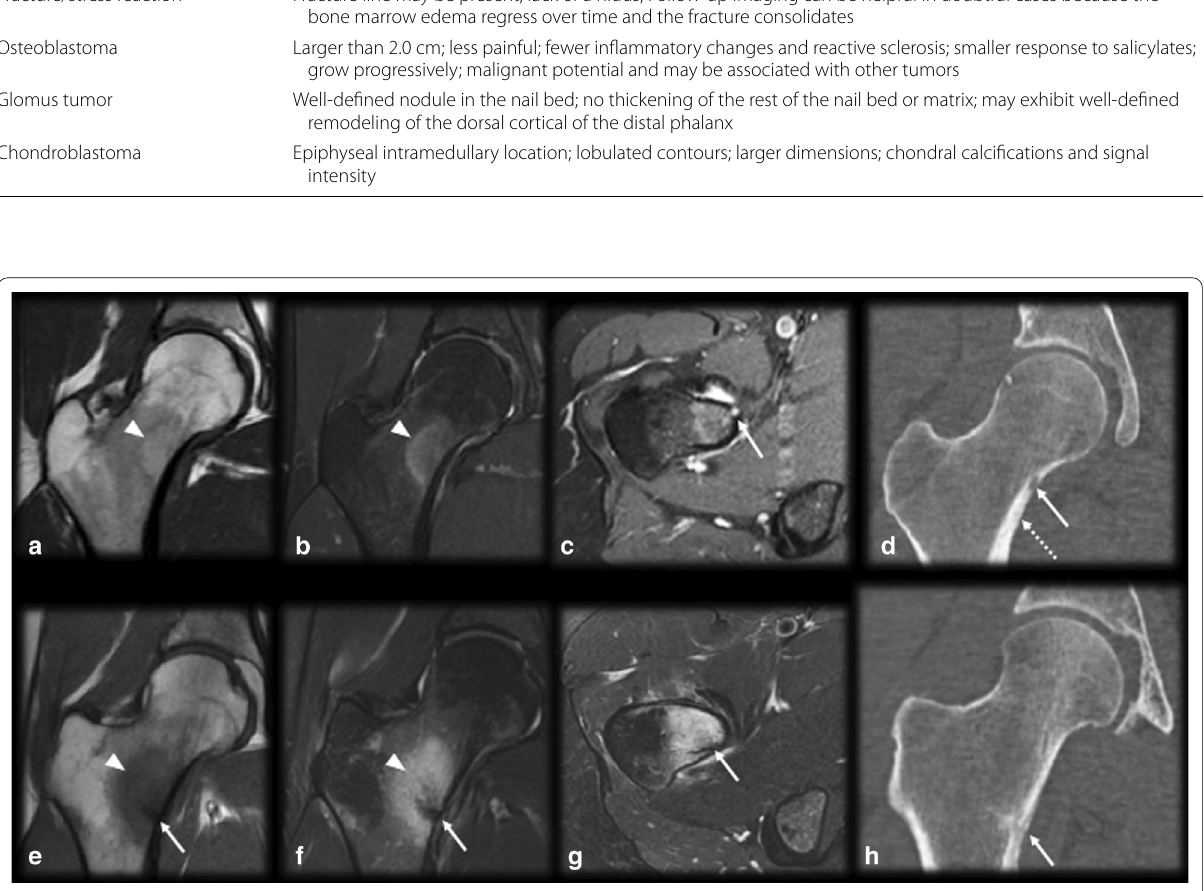
Table 2 Painful OO’s differential diagnoses main imaging findings Differential diagnoses Key points Osteomyelitis/intraosseous abscess Uneven inner margin; irregularly shaped and eccentrically located sequestrum; usually intramedullary located and larger than 2.0 cm; does not enhance in its central portion; penumbra sign may be present Fracture/stress reaction